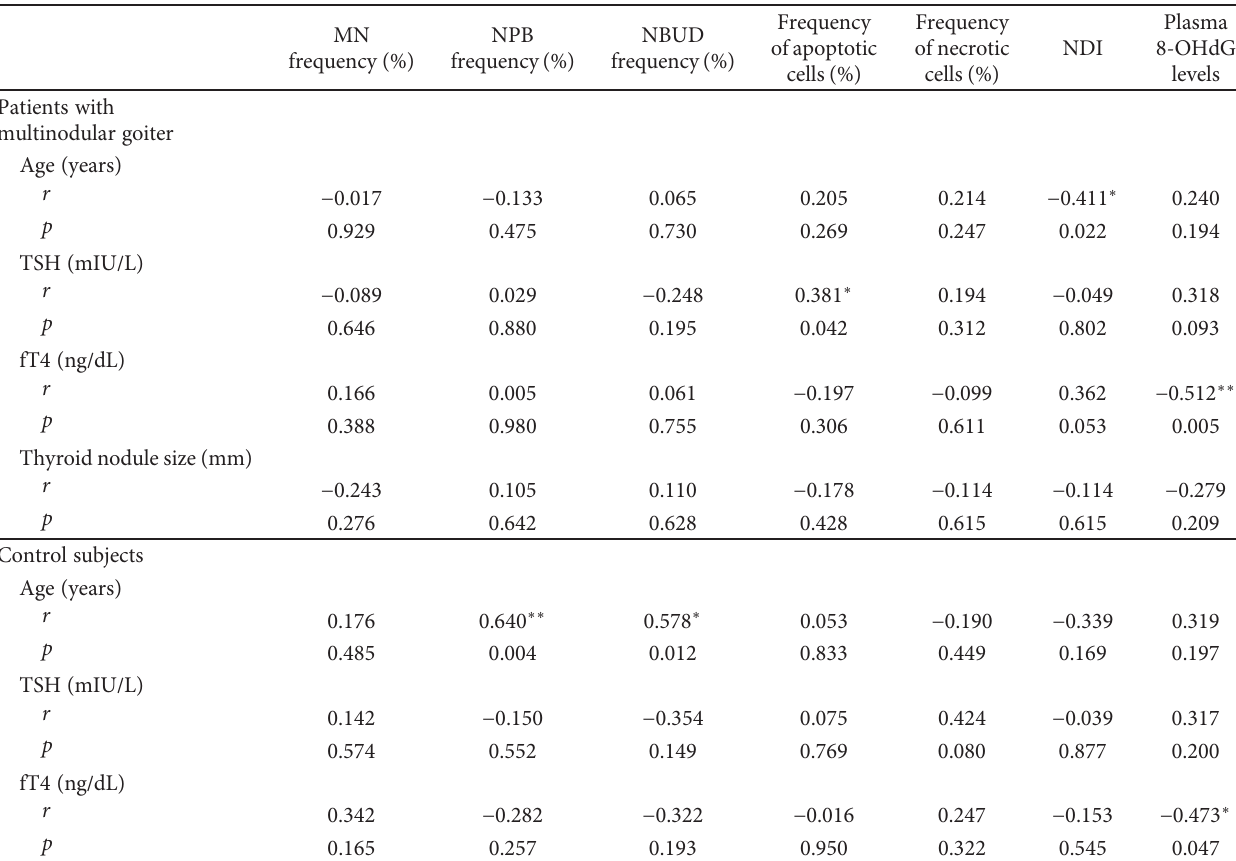
Table 3: Spearman ’ s rho correlation coe ffi cient and signi fi cance values for age, TSH, fT4, and thyroid nodule size with CBMN-cyt assay parameters and plasma 8-OHdG levels in patients with multinodular goiter and control